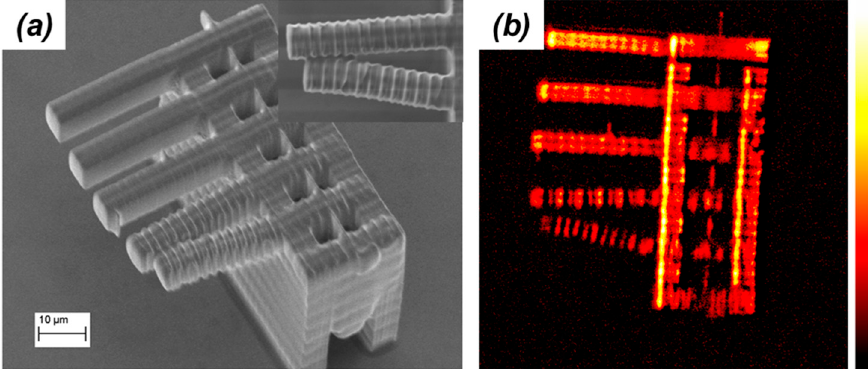
Figure 12. TPP microstructure imaged by ( a ) SEM and ( b ) CARS microscopy. The inset in ( a ) shows a top and magnified view of the bottom two cantilevers. The false color CARS image is made of pure resonant signal at around 3000 cm − 1 . Reproduced from [56].